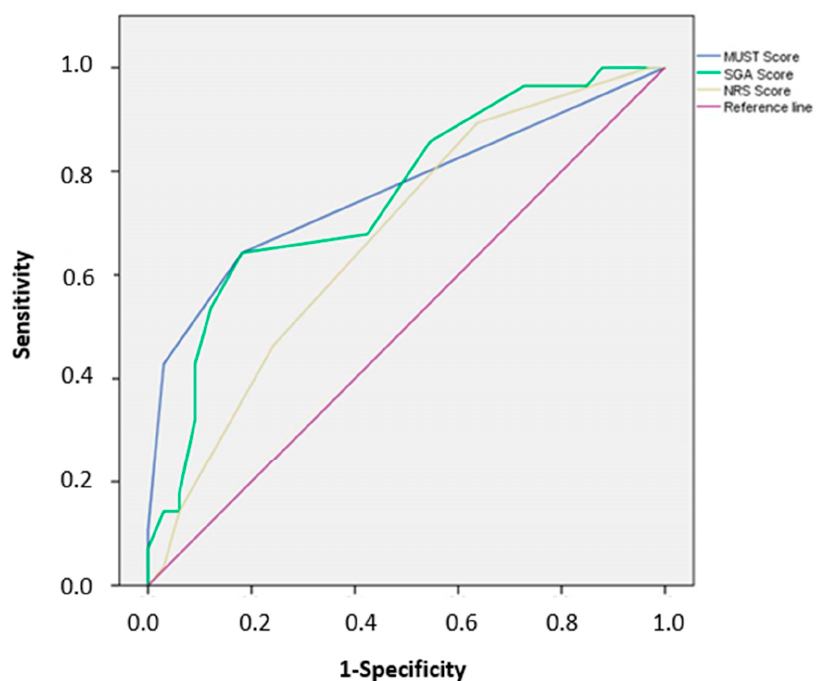
Figure 3. Receiver Operating Characteristic (ROC) curve for prediction of malnutrition based on the score obtained by the Malnutrition Universal Screening Tool (MUST, blue line), the Subjective Global Assessment (SGA, green line), and the Nutritional Risk Screening 2002 (NRS-2002, yellow line).